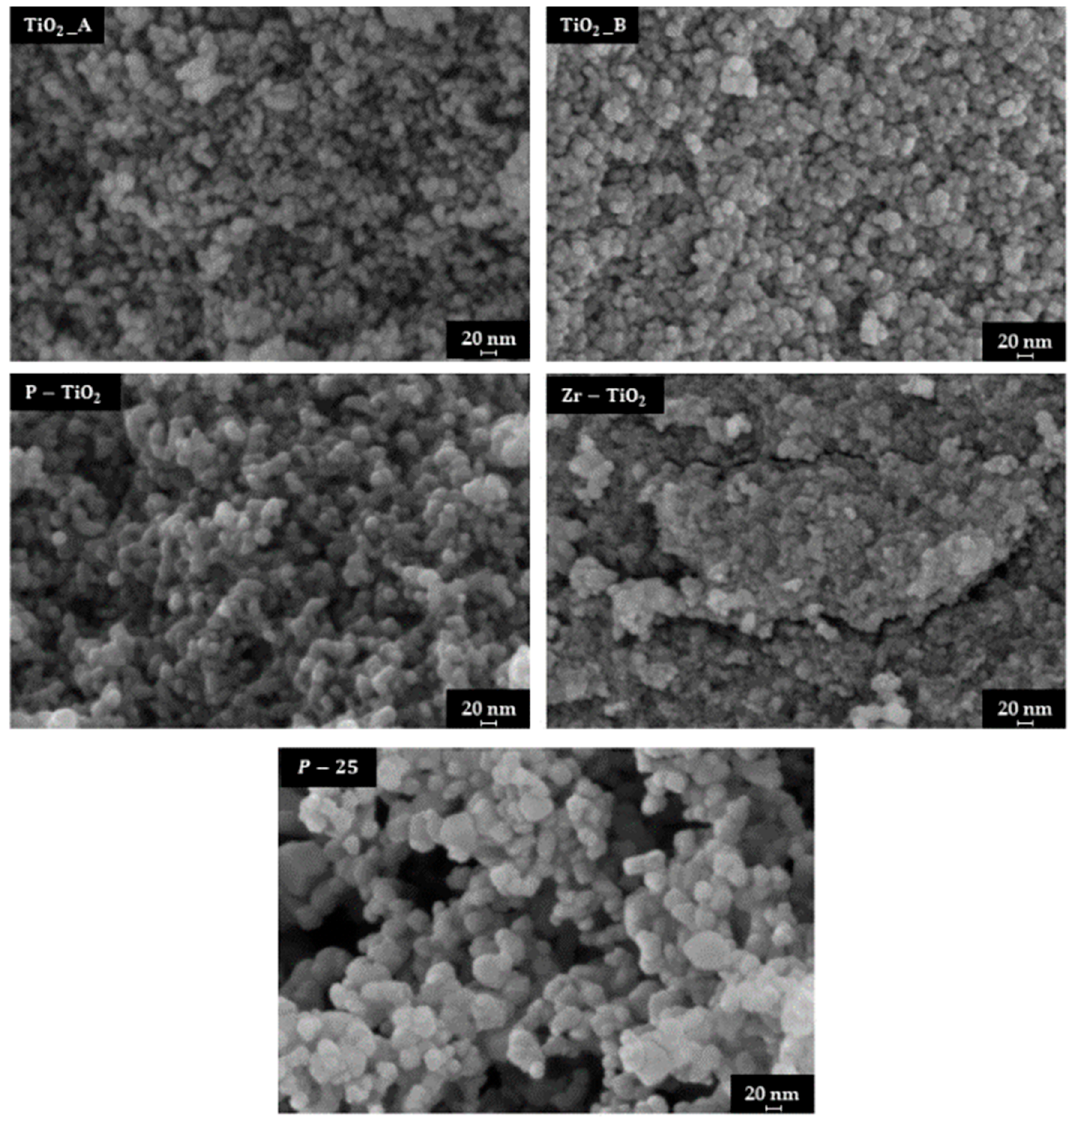
Figure 2. Field emission scanning electron microscopy (FESEM) micrograph of the sample studied.